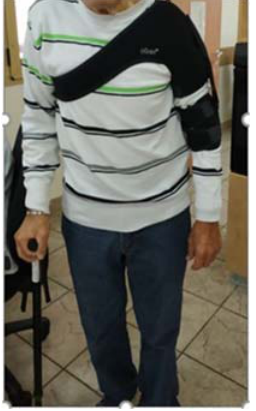
Figure 2. Example of shoulder